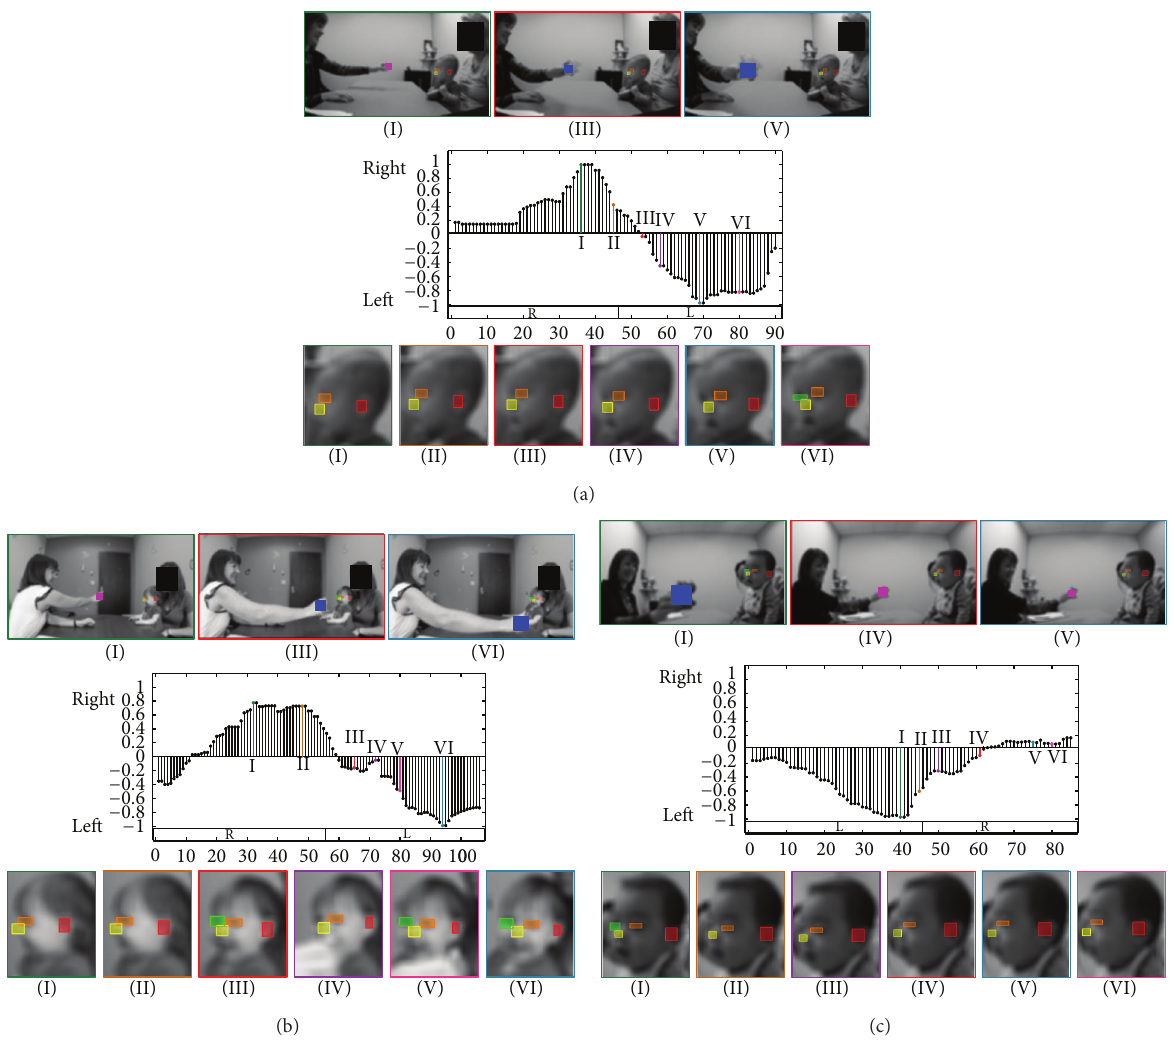
Figure 3: (a) First example of the Visual Tracking task. Top: when the clinician is holding the object, when the object is at one extreme side (right or left), and when the object is at the other extreme side. Middle: changes in the yaw motion ( ̂ yaw values in the 𝑦 -axis; see Appendices A and B) for every frame ( 𝑥 -axis). The boxes labeled “R” and “L” represent when the object is to the right and left of the participant, respectively. The gray shaded areas represent when the object is not moving and at an extreme side (either right or left). Bottom: 6 examples of the infant’s face during the task. Colors and roman numerals identify corresponding images and spikes in the graph. (b, c) Two examples of the Visual Tracking